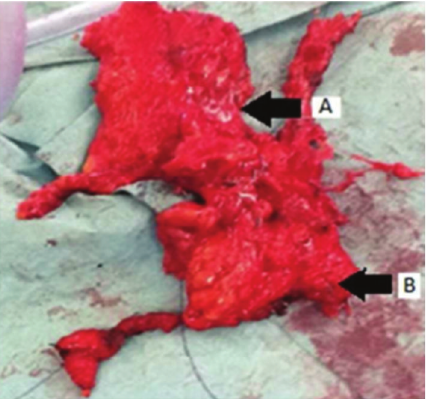
Figure 3: The specimen: the neck dissection attached to the parotid was removed as one entity. The neck dissection consisted of lymph nodes 1A, 1B, 2A, and 2B and level 3. A: body of parotid gland. B: level 2A